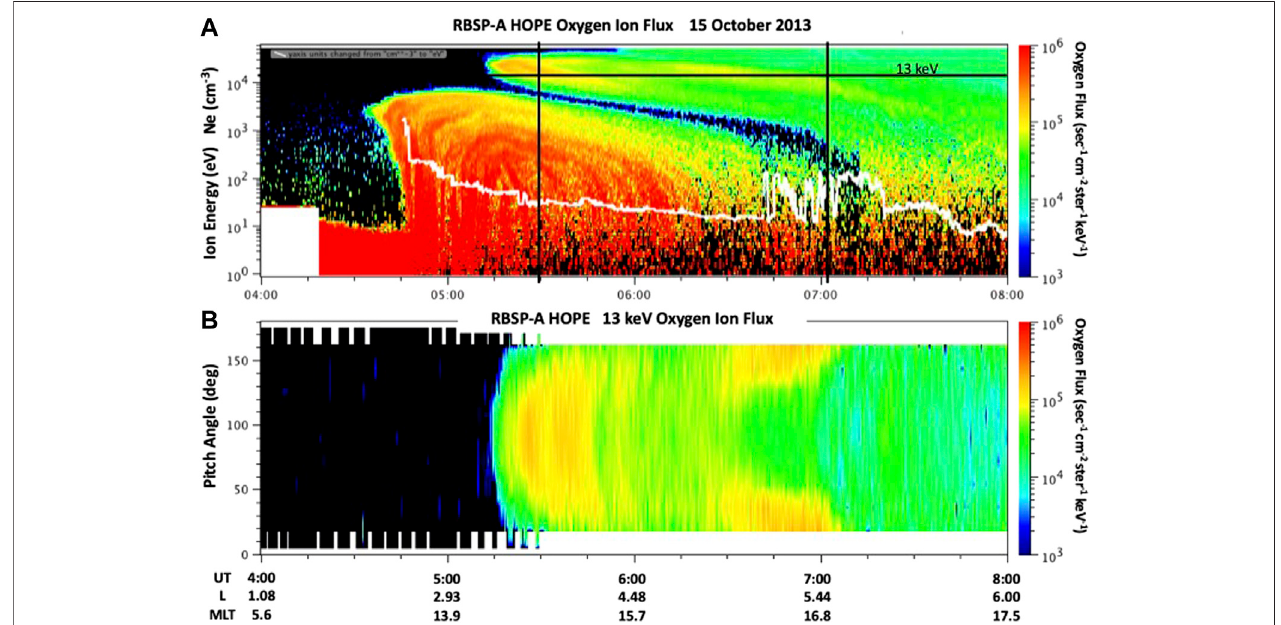
FIGURE 3 | (A) HOPE O+ spectrogram [white curve: EFW electron density (cm − 3 )] for the outbound orbit of RBSP-A shown in Figure 2 . Probe A exits the plasmasphere at ∼ 04:45 UT, observes a wedge-like spectrogram at energies below the ZEAB as it crosses the morningside notch between the plasmapause and the geospace plume, and encounters the plume at06:45 UT. Forreferencewith Figure 4 ,two fi ducialblackvertical lines areshown at 05:30 and 07:02 UT. RBSP-A exited thedusksideoftheplumeat07:20 UT. (B) PancakePADs(peakedat90 ° )characterize thenoseoftheringcurrentO+ions fi rstobservedat 05:15 UTnearL ∼ 3.5 (13 keVionsareshown).Asthemorningsideoftheplumewasencountered,the13 keVO+ionschangedcharactersigni fi cantly,becomingbi-directionally fi